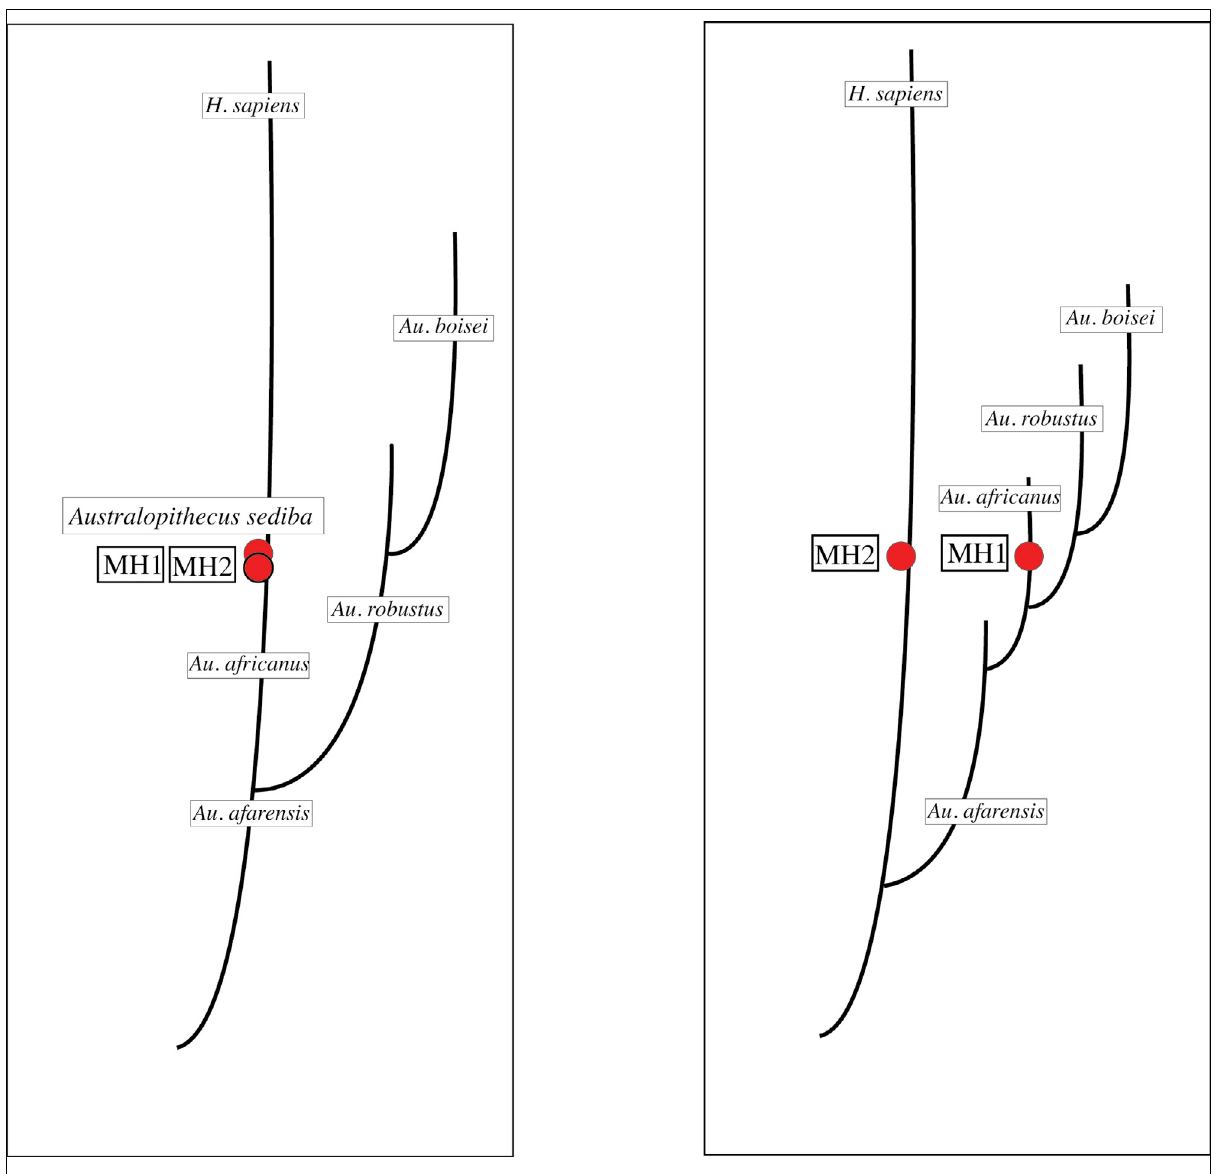
Figure 9: Two proposed phylogenetic trees. The left tree depicts Berger et al.’s 2010 proposal 2 , in which Australopithecus sediba is a link in the chain between Au. africanus and Homo sapiens . The right tree depicts our proposal, in which MH1 lies on the robust clade and MH2 is on the Homo lineage. In addition, an analysis of the MH1 skull indicates that there is no reason to exclude it from the Au. africanus hypodigm. 23 The Au. afarensis mandibular ramus is too derived to allow us to place it on the Homo lineage. We have placed Au. africanus on the robust